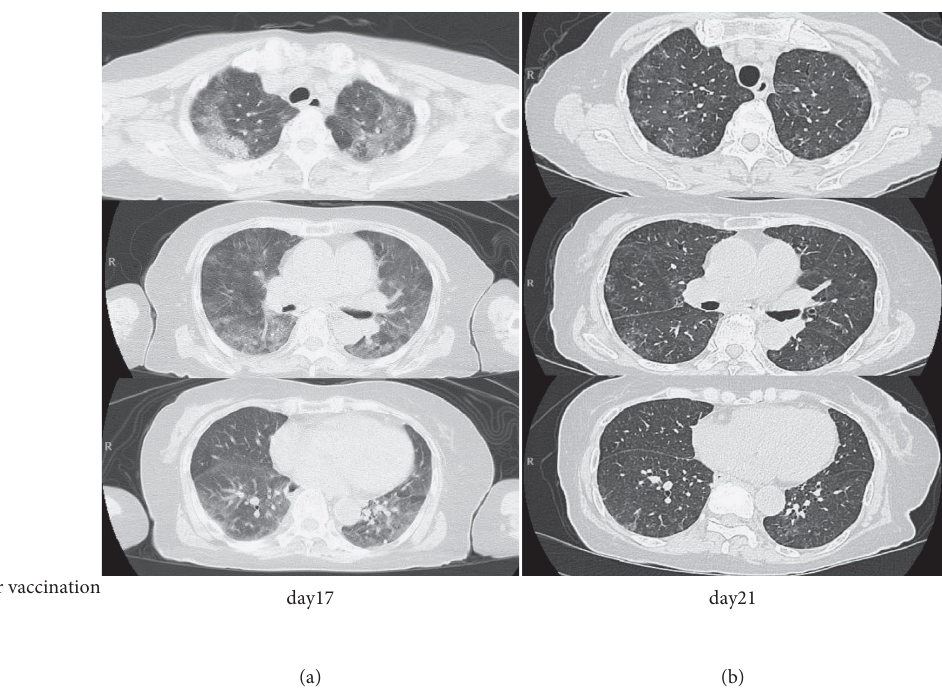
Figure 1: Chest computed tomography scans showing changes in the lung lesions. (a) CTscan performed on Day 17. (b) CTscan performed on Day 21. The second CTscan shows a clear improvement compared to the CTscan performed 4 days earlier. CT: computed